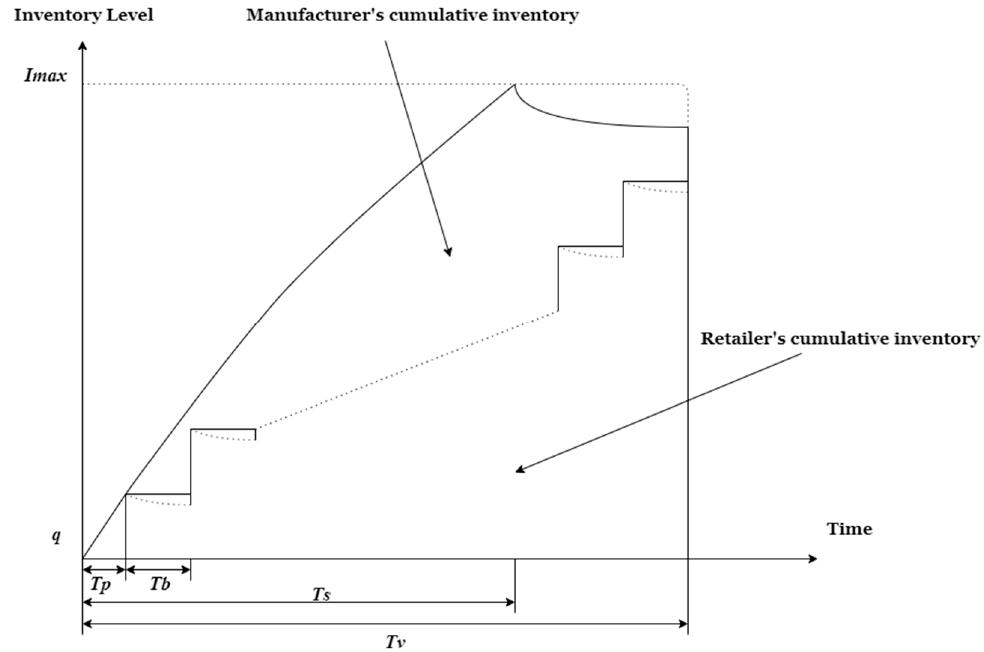
Figure 3. Manufacturer’s and retailer’s cumulative inventory of finished goods.